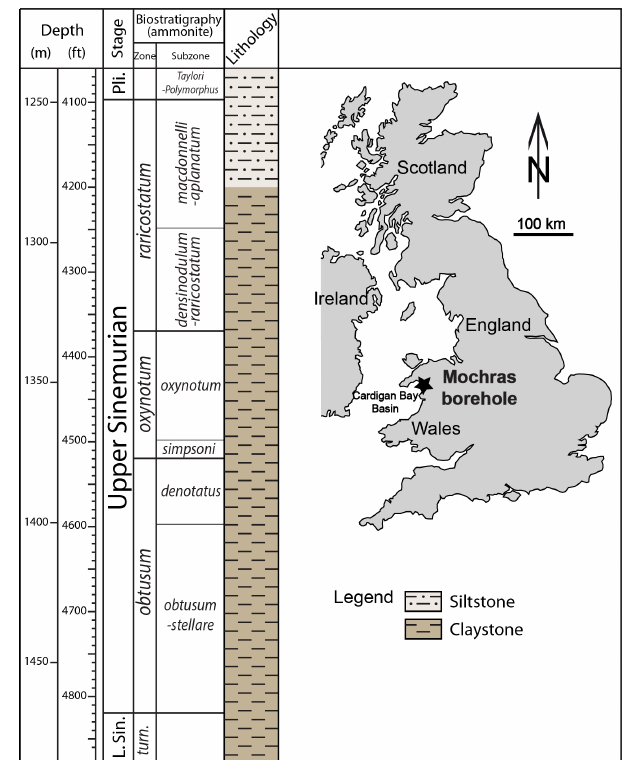
Figure 2. Location map of the Mochras borehole, simplified lithol- ogy, and biostratigraphy of the upper Sinemurian (from Copestake and Johnson, 2014). Abbreviations: L. Sin. – lower Sinemurian, Pli. – Pliensbachian, turn. – turneri